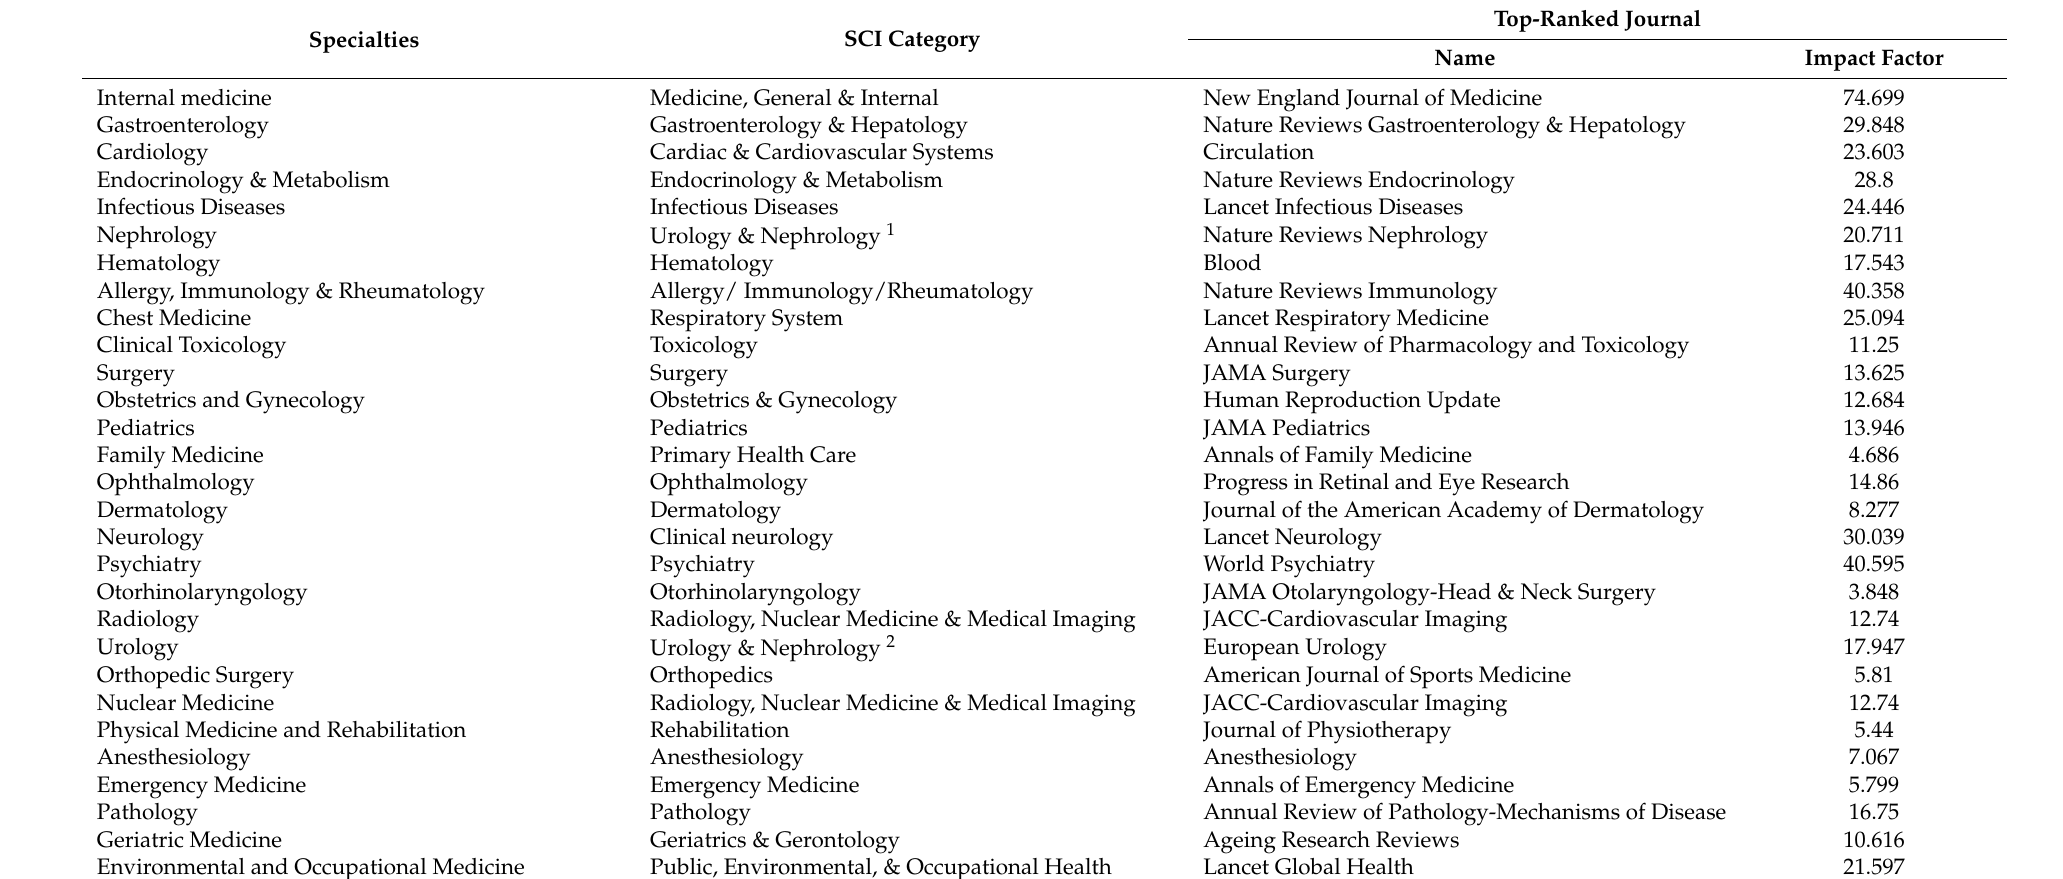
Table 6. Top-ranked journals of medical specialties and